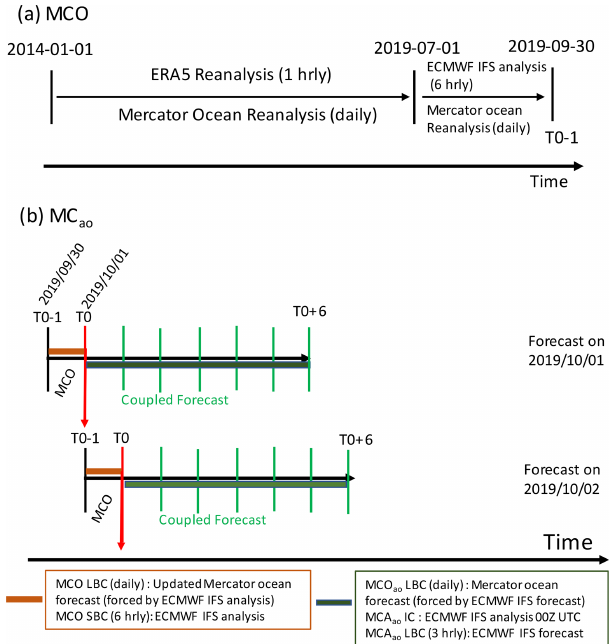
Figure 2. Schematic of modelling systems used in the study: (a) MC ocean-only model (MCO) hindcast and (b) MC atmosphere– ocean coupled forecast model (MC ao ). MCO ao stands for the MC coupled ocean model, MCA ao stand for the MC coupled atmo- spheric model, LBC stands for the lateral boundary condition, SBC stands for the surface boundary condition, IC stands for the initial